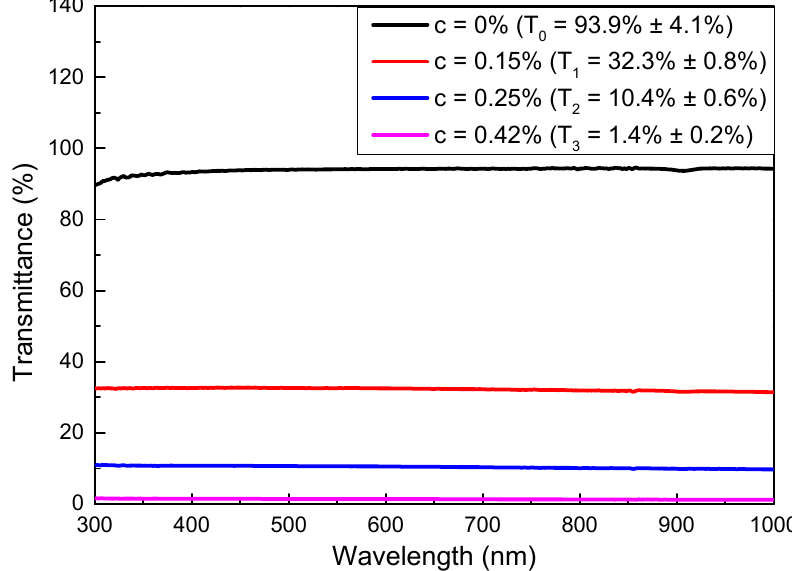
Figure 2. Four transmission lines for the pure PDMS sample and the three concentrations (0%, 0.15%, 0.25% and 0.42%) of microcrystalline graphite powder composites in the polydimethylsiloxane (PDMS) samples within the 300–1000 nm wavelength